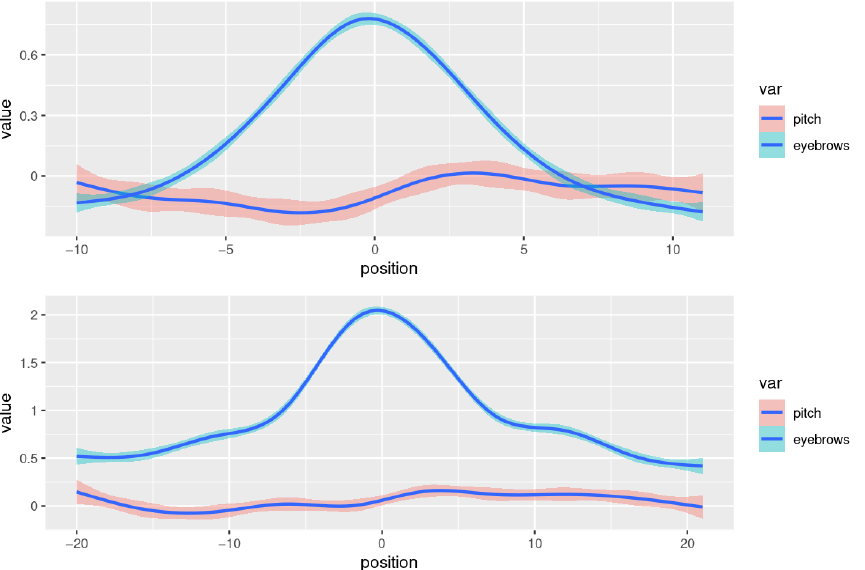
Figure 6. Smoothed curves showing the eyebrow height (blue) and pitch value (red) of the speaker sample, with 95% confidence intervals for the standard errors, for segments with an eyebrow peak of < 1.5 standard deviations (top plot) and an eyebrow peak of > 1.5 standard deviations (bottom plot). The smoothing curves show generalized additive models fitted to the data (k =